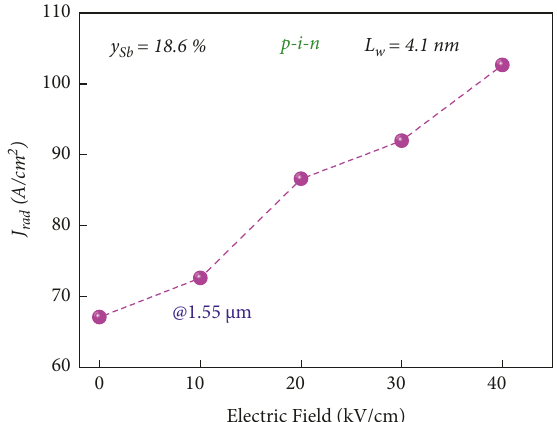
Figure 4: The radiative current density as function of applied electric field F varying from 0 up to 40kV/cm for p-GaAs/i- GaN 0.38y As 1–1.38y Sb y /n-GaAs QW structure operating at 1.55 μ m telecommunication wavelength. The Sb composition and the well width are y Sb � 18 . 6% and L w � 4 . 1nm,